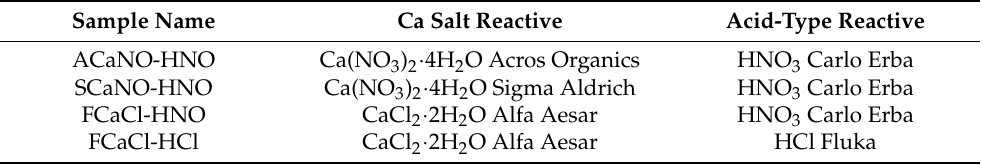
Table 1. Synthesis reagents and nomenclature used for the different